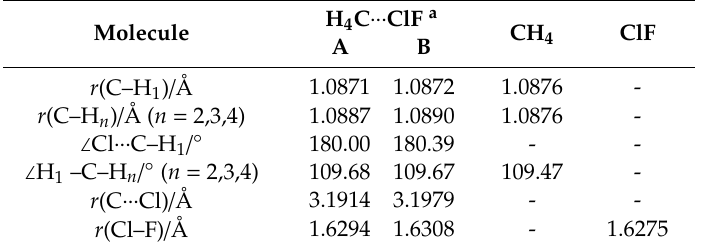
Table 2. Ab initio equilibrium geometries of H 4 C ··· ClF, CH 4 , and ClF optimised at the CCSD(T)(F12c) / cc-pVTZ-F12 level of